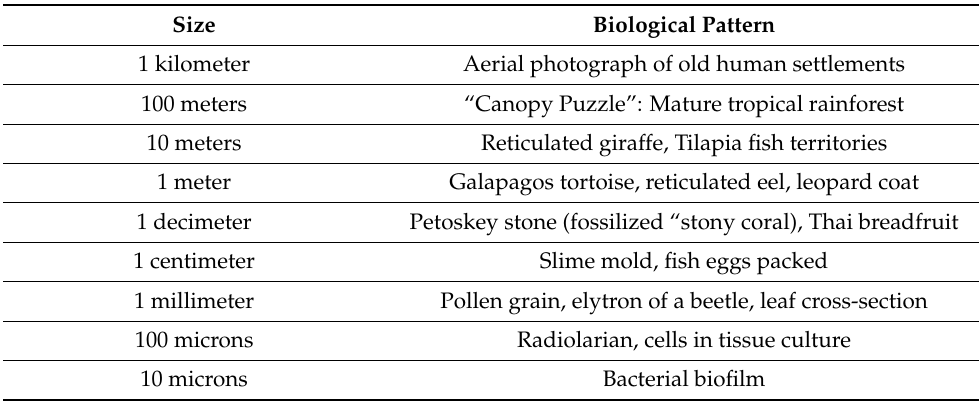
Table 1. Spatial diversity in biological formation of Voronoi